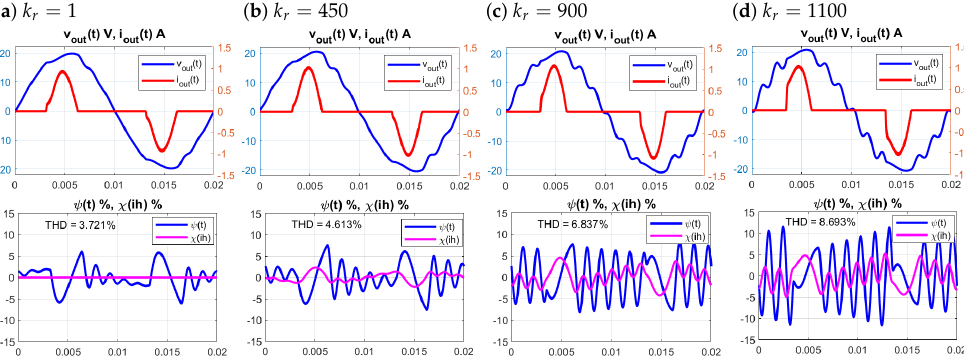
Figure 32. R control at different values of gain k r . ( a ) ∆ A = 964.4, k r = 1, no-load mode is stable; ( b ) ∆ A = 2.143, k r = 450, no-load mode is stable; ( c ) ∆ A = 1.072, k r = 900, no-load mode is stable but close the stability boarder; ( d ) ∆ A = 0.877 < 1, k r = 1100, no-load mode is unstable.